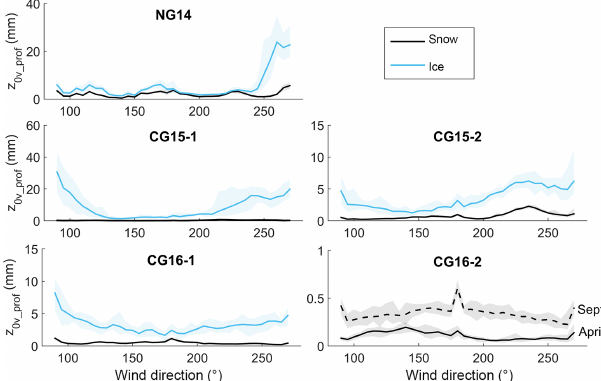
Figure 13. Roughness values from the rotated z 0v_prof method for 5 ◦ increments in wind direction between 90 and 270 ◦ for an April (snow) and September (ice) surface at each station (snow surface present at CG16-2 for both periods). The shaded area represents the range of roughness lengths estimated for the five profiles either side of the station profile (11